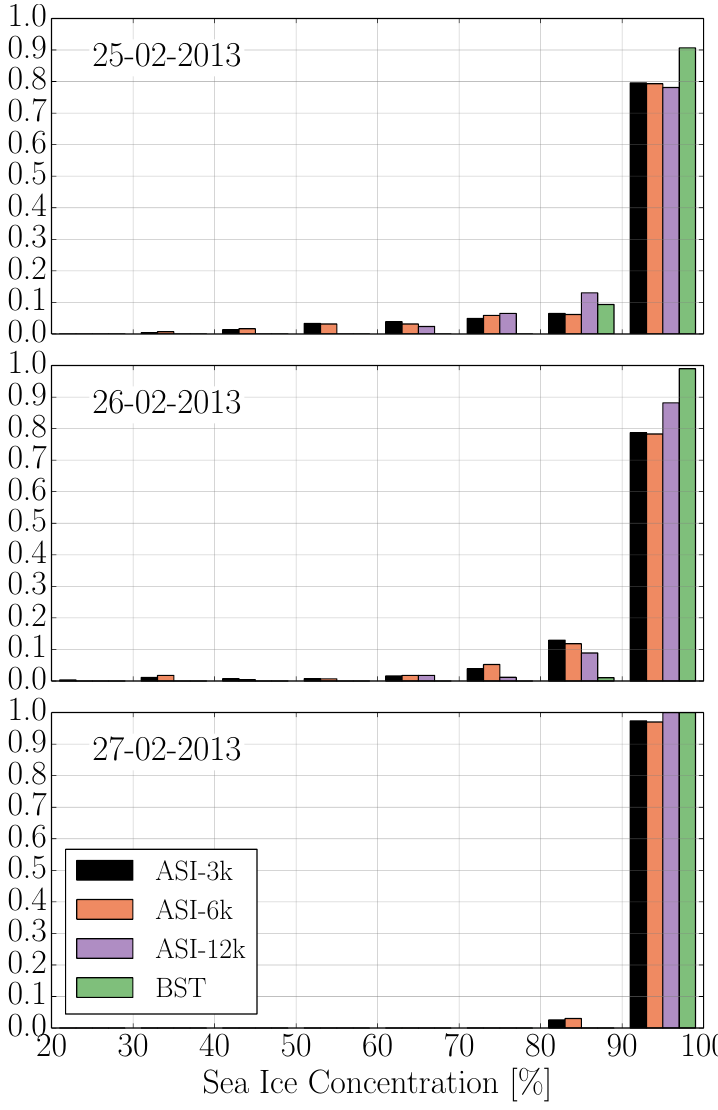
Figure 4. Histogram of the relative probability of SIC in the insets shown in Figures 1–3, respectively. Sea ice concentrations from ASI-3k, ASI-6k, ASI-12k and BST are shown in bins of 10%, for ranges 21%–30%, 31%–40%, ..., 91%–100%. A legend in the lowest panel indicates the different data. Note that the abscissa in the three panels start with